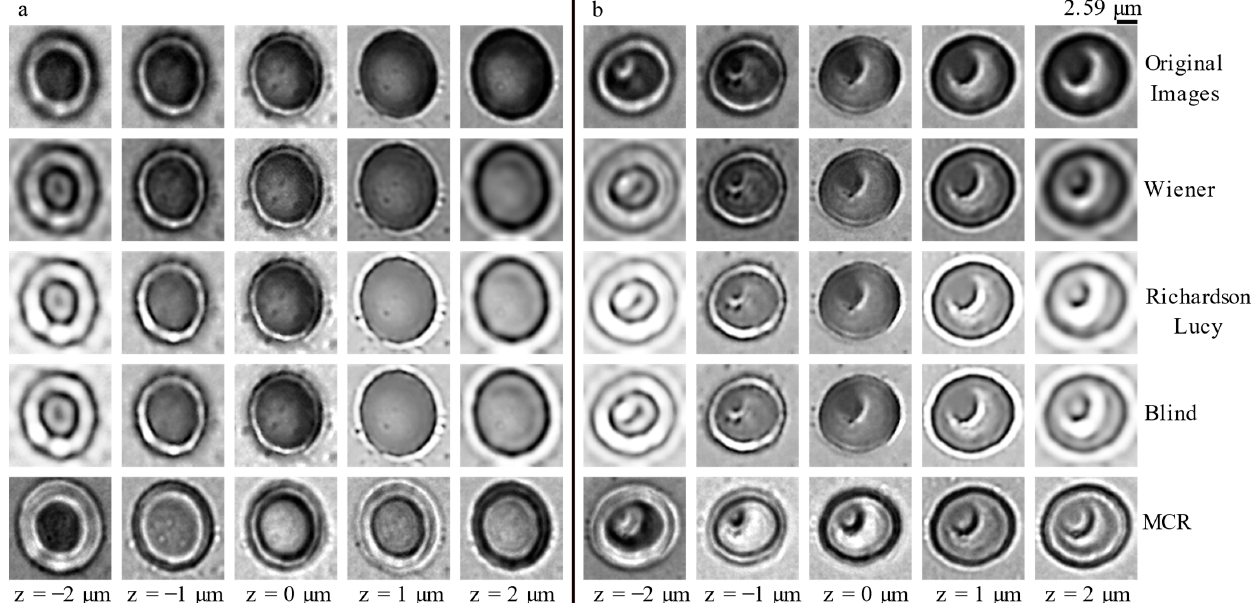
Figure 6. Original, Wiener filtering, Richardson–Lucy, blind deconvolution, and MCR images of assumed-to-be-healthy RBC ( a ) and RBC with a suspected infection ( b ).